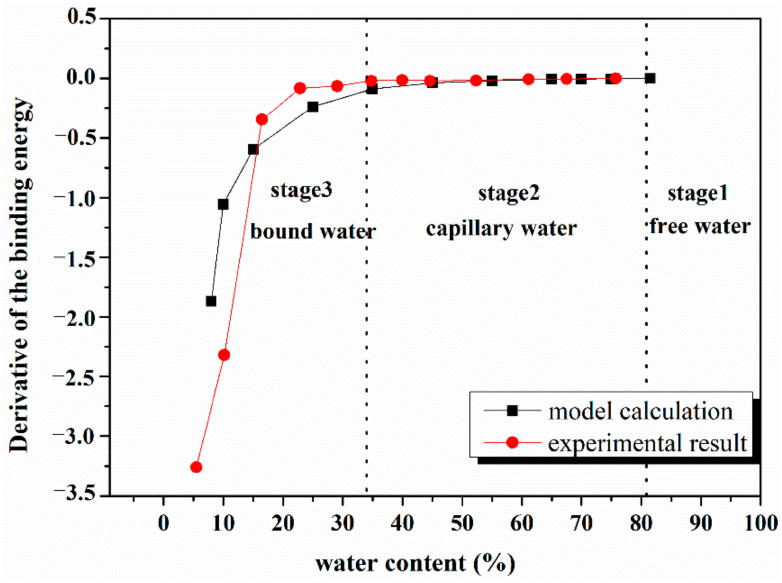
Figure 5. The derivative of the binding energy of the HZ